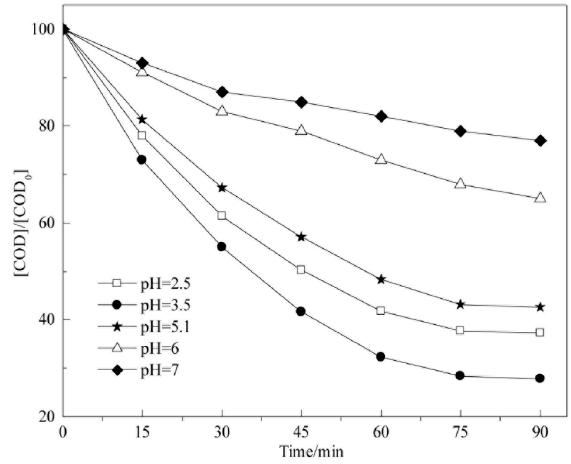
Figure 8. Influence of different initial pH values.